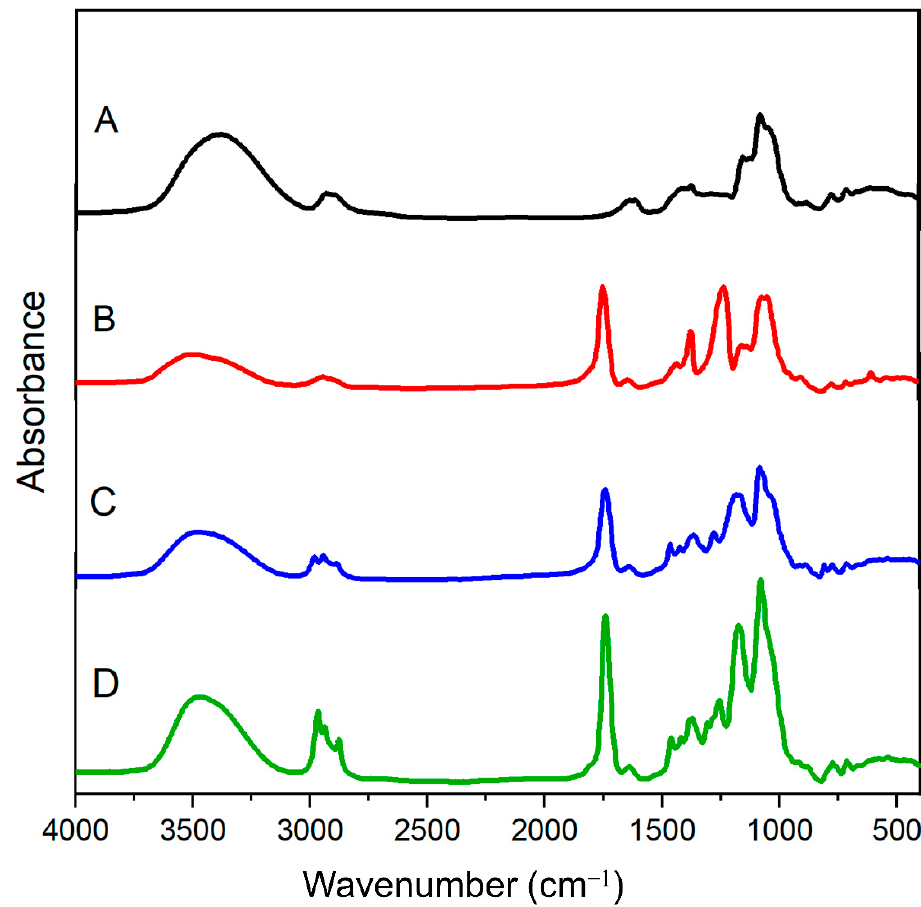
Figure 1. FTIR spectra for cashew gum and acylated derivatives: ( A ) CG; ( B ) CGAc; ( C ) CGProp; ( D ) CGBut.